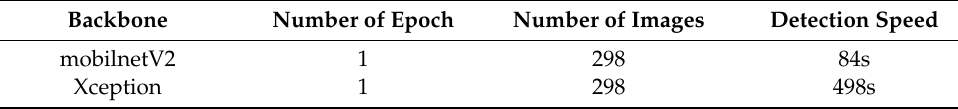
Table 4. The comparisons of detection speed in our dataset.